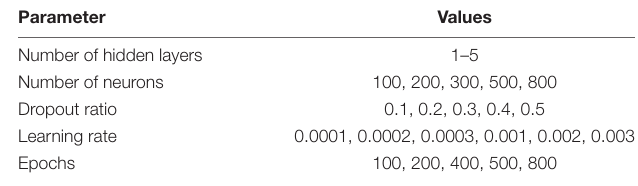
TABLE 3 | Hyperparameter values explored for the DNN